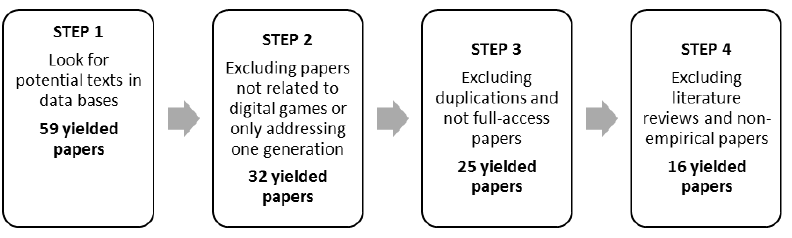
Scheme 1. Steps Systematic